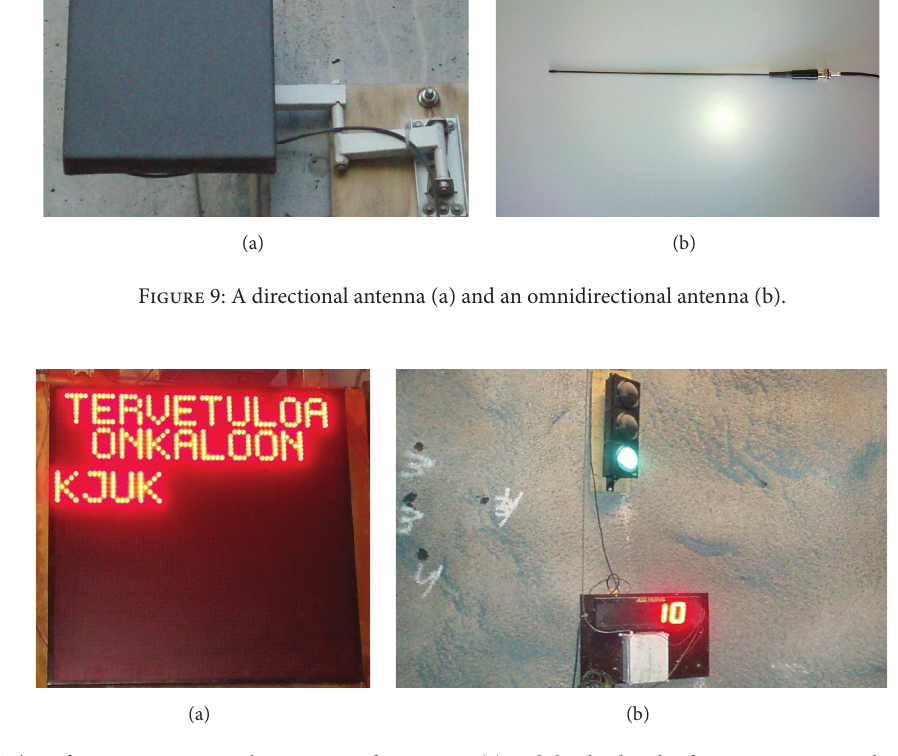
Figure 10: The information screen at the entrance of ONKALO (a) and the dead end information screen and traffic light